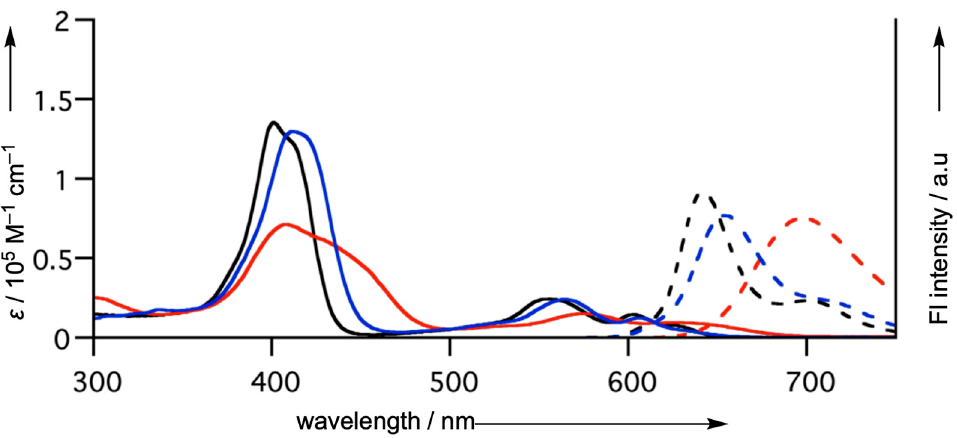
Figure 2. Ultraviolet–visible (UV/Vis) absorption (solid line) and emission (broken line) spectra of 6H (red), 7H (blue), and 4 (black) in CH 2 Cl 2 . Table 1. Summary of the absorption and emission spectra of 4 , 5H , 5Ag , 6H , 7H , and 8 in CH 2 Cl 2 . Compound Absorption peaks/nm